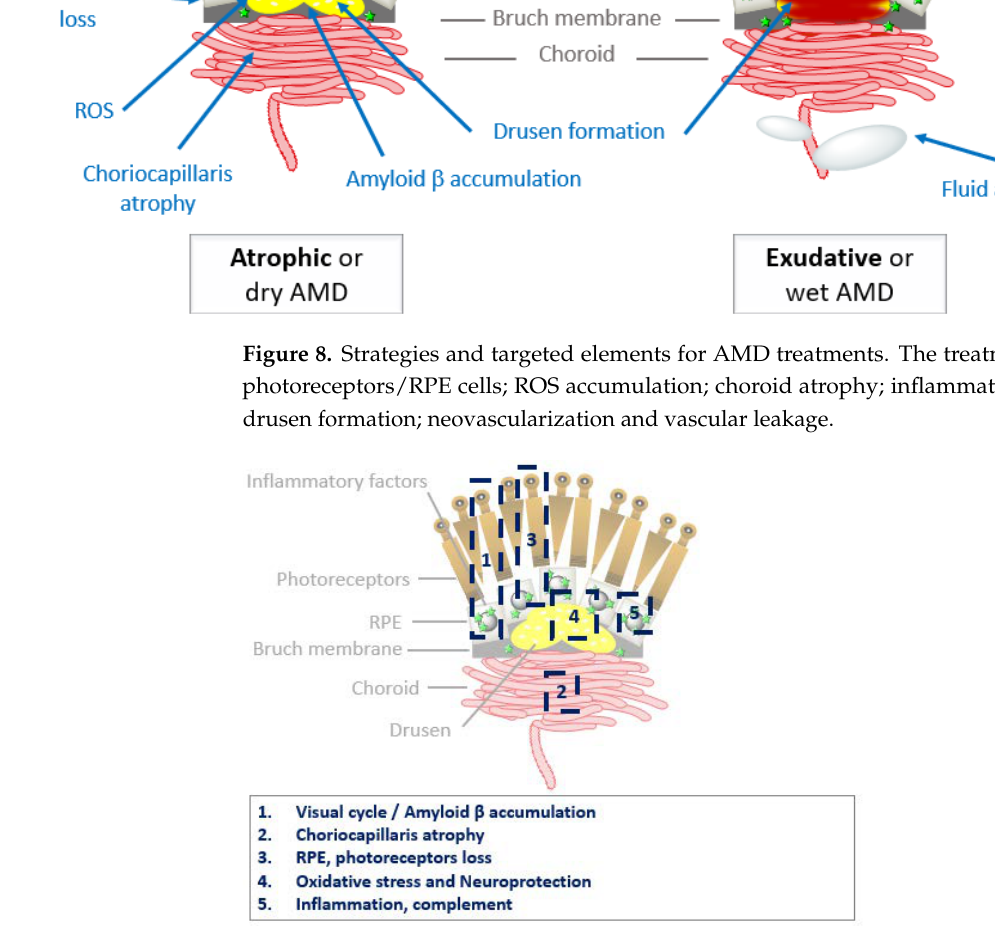
Figure 9. Current therapeutic targets for the treatment of atrophic AMD.